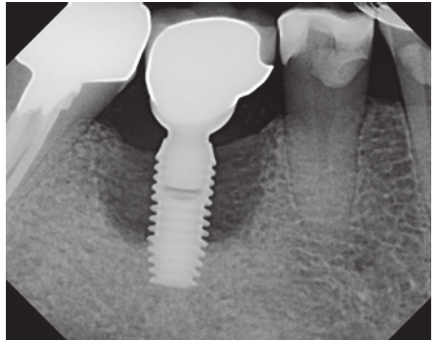
Figure 23: Six years following treatment. The patient has finally consented to having the implant removed and the site regrafted and evaluated following healing for possible future implant